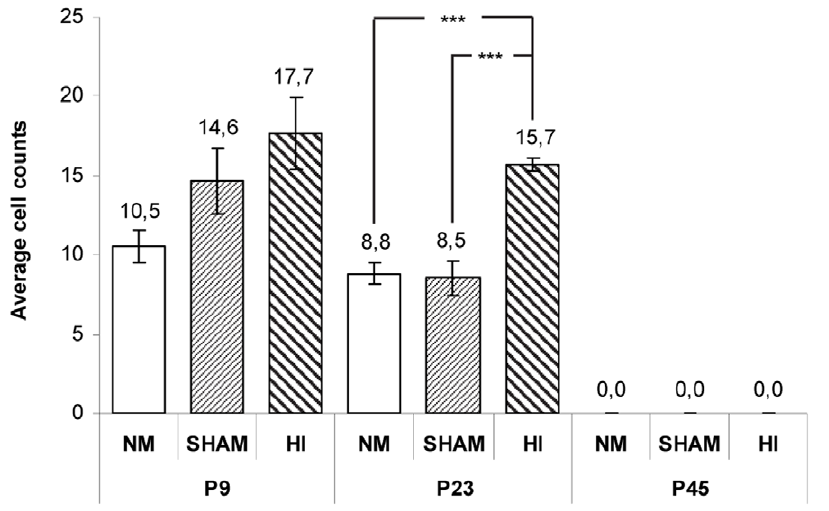
Figure 5. Average cell numbers per 100 m m 2 in the cerebellar white matter of HI, SHAM and NM animals at P9, P23 and P45. 5 animals in each age from at least 3 different litters per group were used (maximum of 2 pups per dam). Note that, at P23, the number of cells in HI group is significantly higher than in the SHAM and NM and that no difference was observed between these last two groups. At P45 no NADPH-d + cells were observed in all groups. *** P , 0.001.